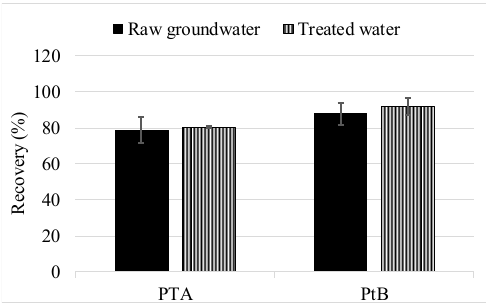
Figure 6. Validation of the SPE method for two water types in the lab (95% confidence limit; n = 6). The error bars represent relative standard deviation (RSD).